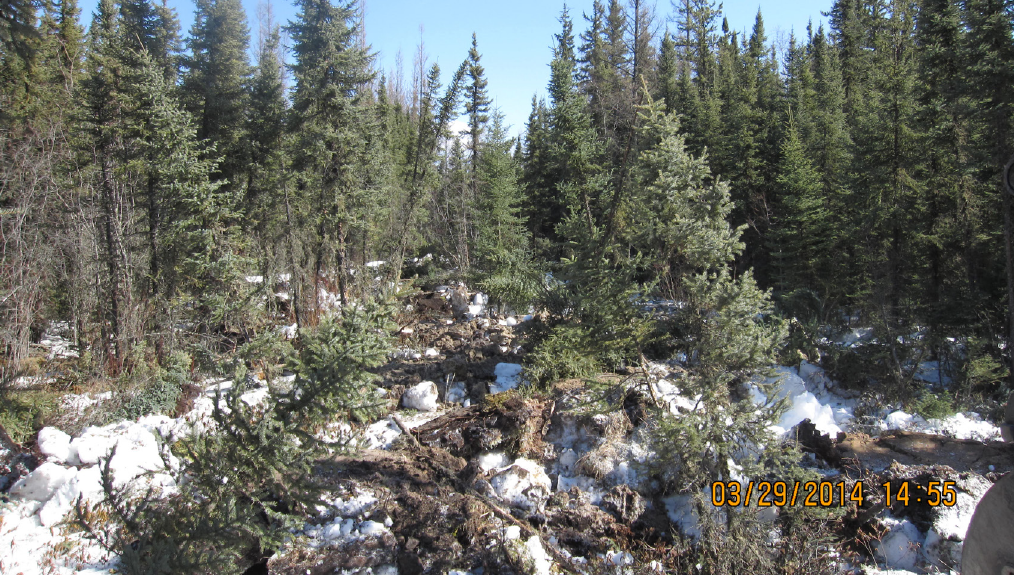
Figure 6. Lease road after treatment with mounding, tree-felling, tree-bending, and tree transplanting. Photo courtesy of MEG Energy.